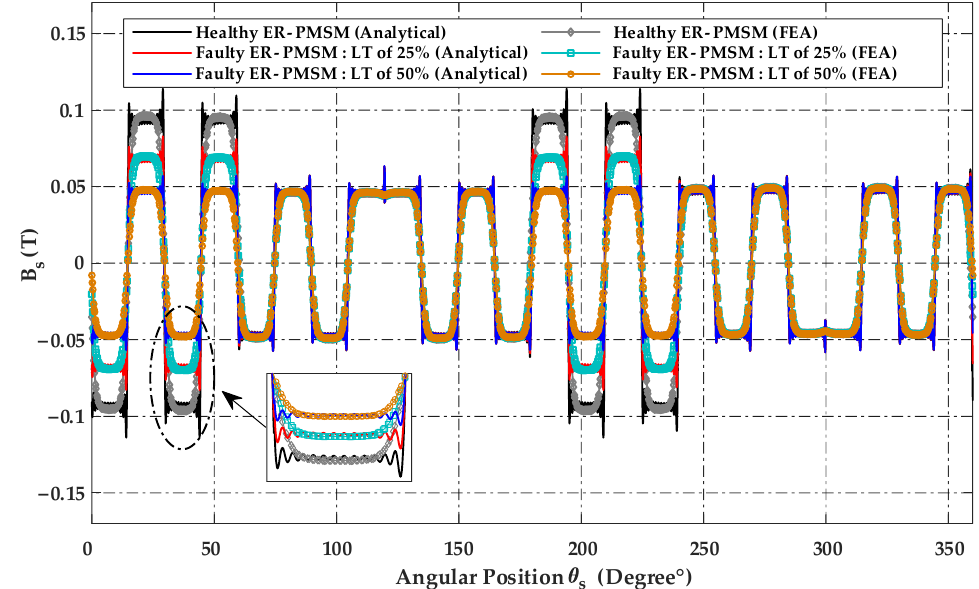
Figure 9. Air-gap flux density distribution in the healthy and faulty cases.